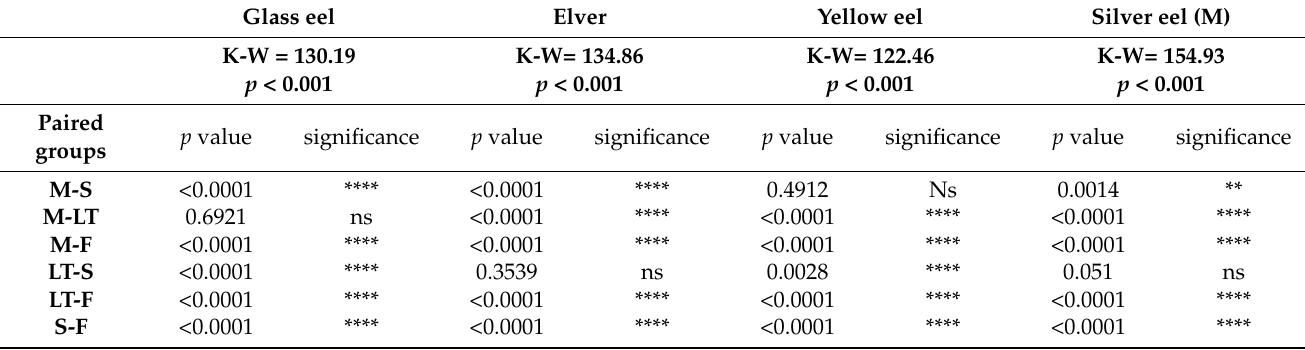
Figure 6. Dendritic spine density per 10 μm of dendritic trunk length ± SEM, grouped for eels’ life stage and for spine class. Bars are repartitioned according to the life stage of eels and the den- dritic spine class, respectively (M: mushroom in yellow, LT: long thin in blue, S: stubby in red, F: filopodia in pink).